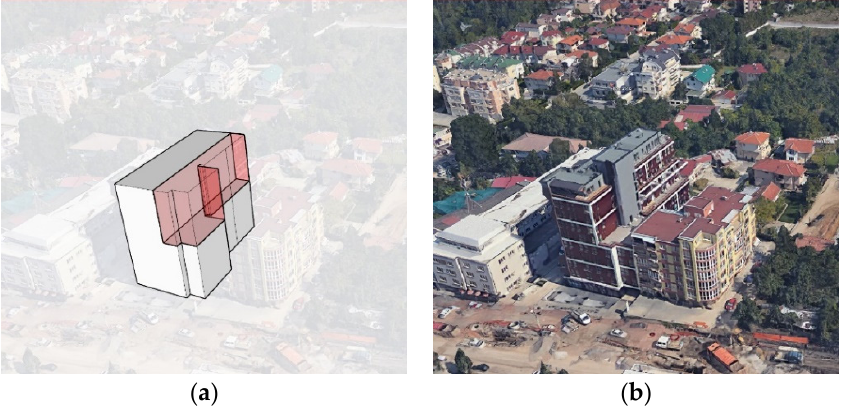
Figure 7. ( a ) Solid building model with subtracted volume in red and ( b ) building shown in Google Earth.